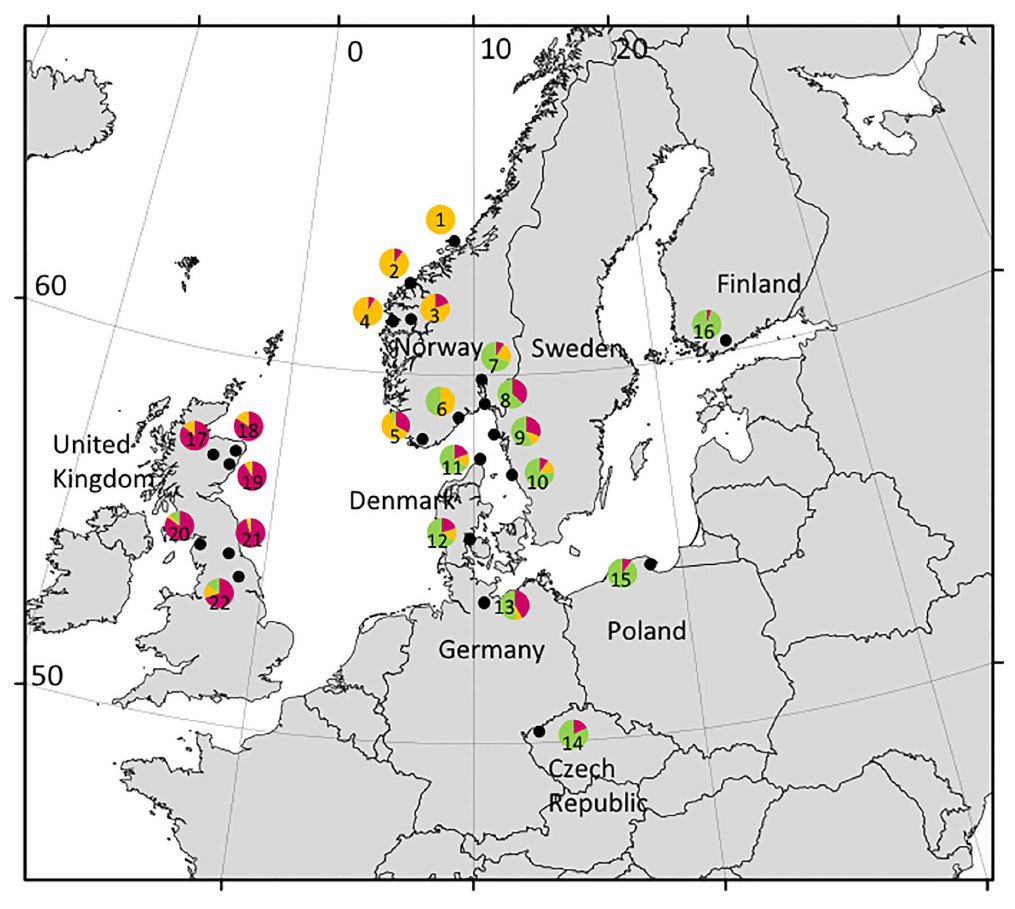
Fig 1. Sampling sites of Ixodes ricinus . Locationsgiven as black dots. Pie diagrams show the proportionof the three mtDNA lineagesfor each site, with the GB lineagecolored in burgundy, the WNo lineagein orangeand the Eu lineagein green. Numbers within pie diagrams refer to the site numberas given in Table 1. (Map made from www. naturalearthdata.com).